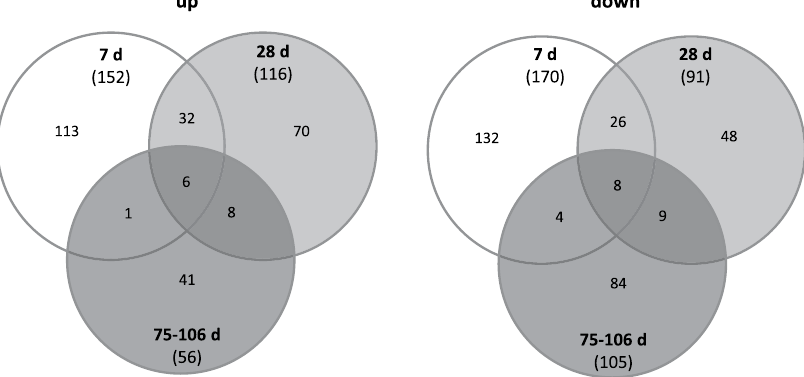
Figure 1. Venn diagrams showing the number of up- (left side) and down-regulated (right side) protein coding genes (mRNA transcripts) observed at 7, 28 and 75–106 days after radiation exposure. The number of differentially expressed genes (DEG) observed on one, two or all three time points after exposure is shown in the corresponding overlapping circles. Numbers in parenthesis represent the total number of differentially expressed genes.